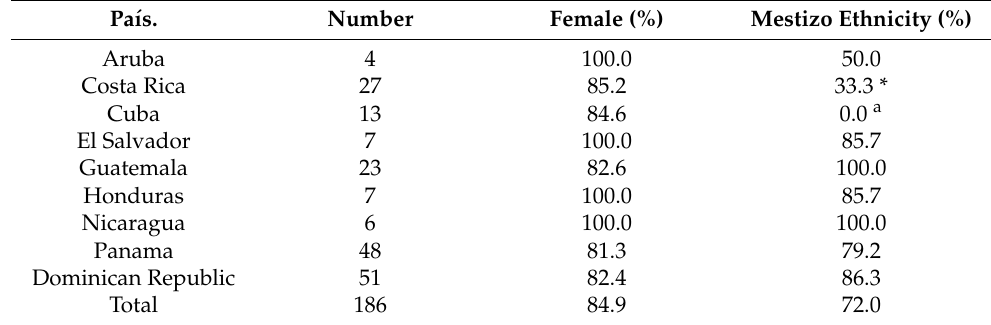
Table 1. Demographic characteristic of NMOSD patients from Central America and the Caribbean. Pa í s. Number Female (%) Mestizo Ethnicity (%) Aruba 4 100.0 Costa Rica El